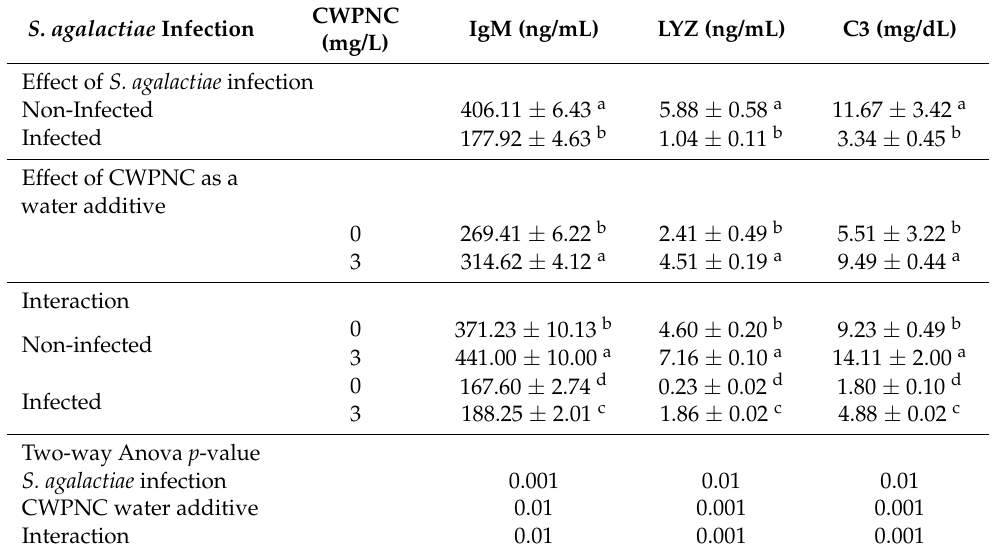
Table 7. Effect of S. agalactiae infection and/or CWPNC as water exposure on immunological biomarkers of O. niloticus for seven